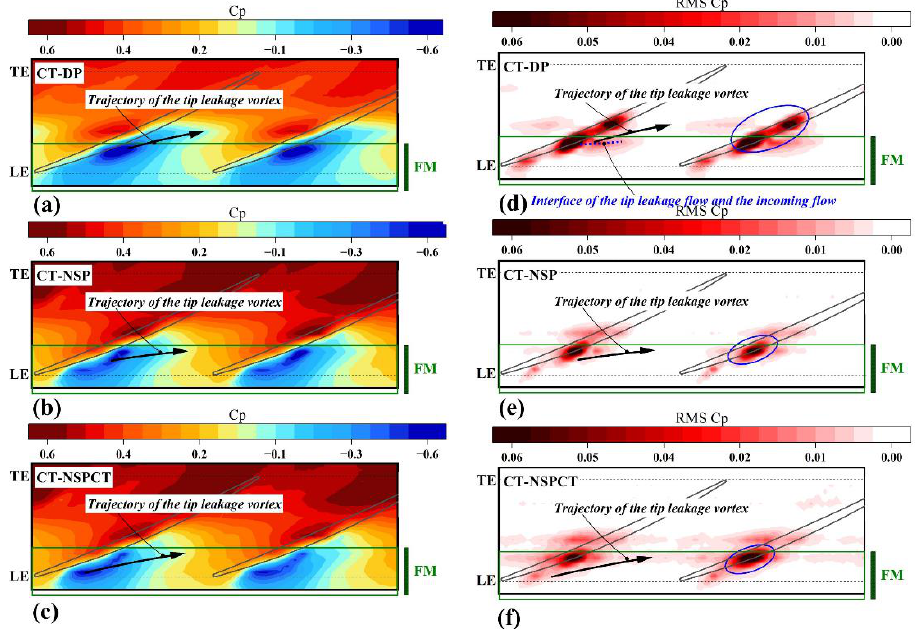
Figure 17. Evolution of the tip flow structure of the compressor with casing treatment . ( a ) C p con- tours at DP, ( b ) C p contours at NSP, ( c ) C p contours at NSPCT, ( d ) RMS C p contours at DP, ( e ) RMS C p contours at NSP, ( f ) RMS C p contours at NSPCT